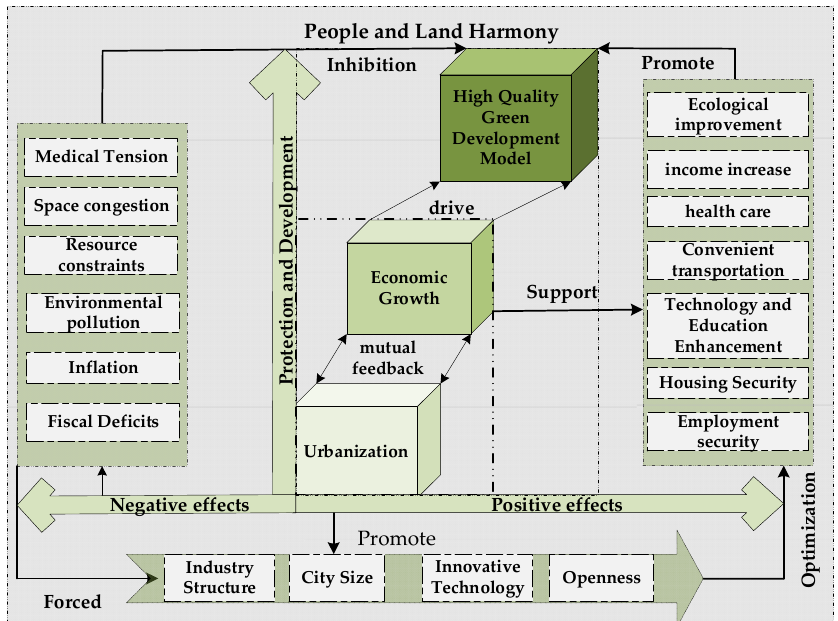
Figure 6. Driving effect mechanism of urban ecological welfare performance.